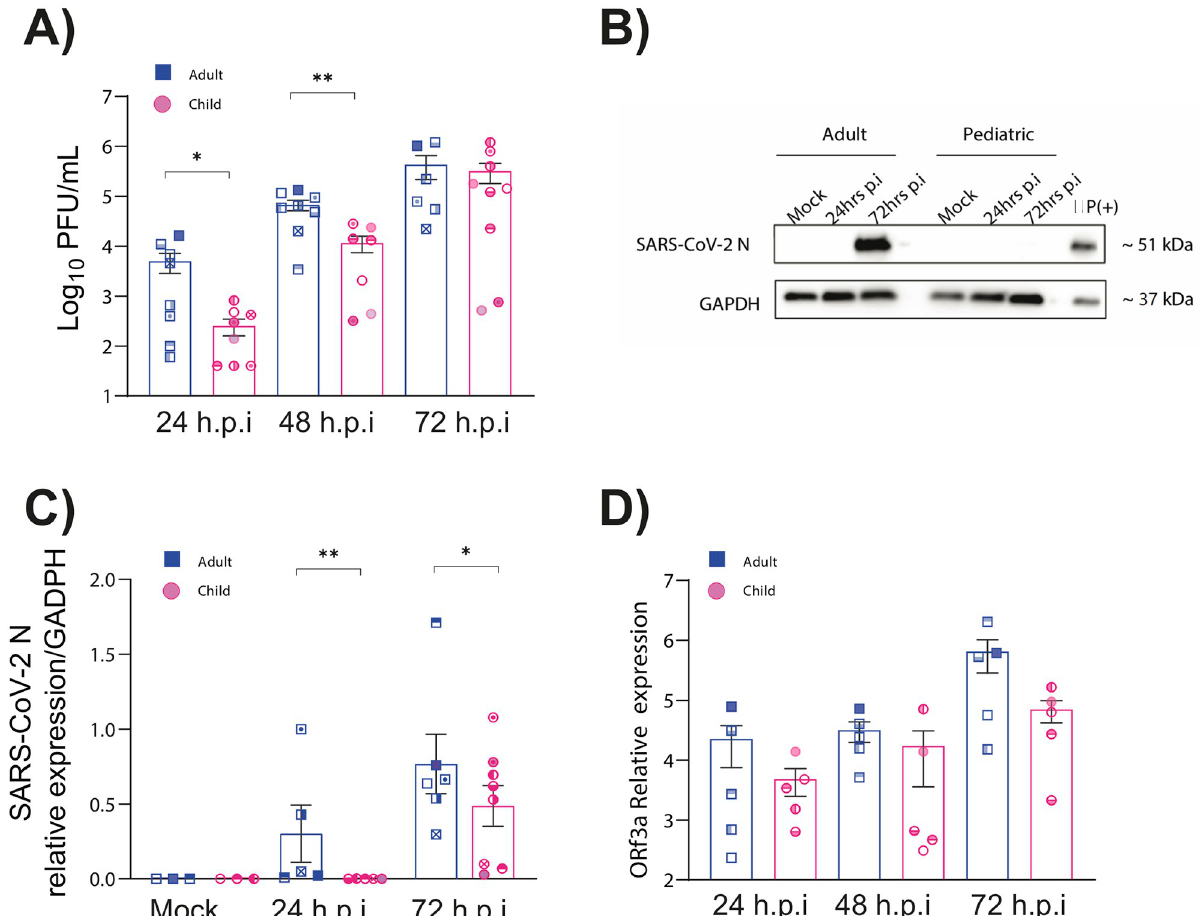
Fig 2. Lower replication of SARS-CoV-2 in pediatric nasal epithelial cells. ( A ) PFUs of SARS-CoV-2 (QLD02) from the apical surface of NECs ( N = 8 adults: 5 females, 3 males and N = 10 children: 5 females, 5 males) obtained at 24, 48, and 72 h.p.i. Cells were infected with 1.25 × 10 5 PFU. ( B ) Representative western blot of adult and pediatric donor blotted for SARS-CoV-2 NP at various time points post-infection. All the western blot results for SARS-CoV-2 NP are shown as S2 Fig. ( C ) Relative SARS-CoV-2 NP levels compared to GAPDH in pediatric and adult NECs. � NP levels of 1 pediatric donor at 24 h.p.i are missing. ( D ) Expression of ORF3a RNA (log10) in infected cells at various time points relative to HPRT expression. Each donor is indicated by unique symbol that is used consistently throughout all figures. Mean ± SEM is shown. p < 0.05 � , p < 0.01 �� . Statistical analysis performed as described in the Materials and methods. Data are contained in S1 Data, and raw western blot images are available in S1 Raw images. GAPDH, glyceraldehyde 3-phosphate dehydrogenase; HPRT, hypoxanthine-guanine phosphoribosyltransferase; h.p.i, hours post-infection; NEC, nasal epithelial cell; NP, nucleoprotein; PFU, plaque-forming unit; SARS-CoV-2, Severe Acute Respiratory Syndrome Coronavirus 2.